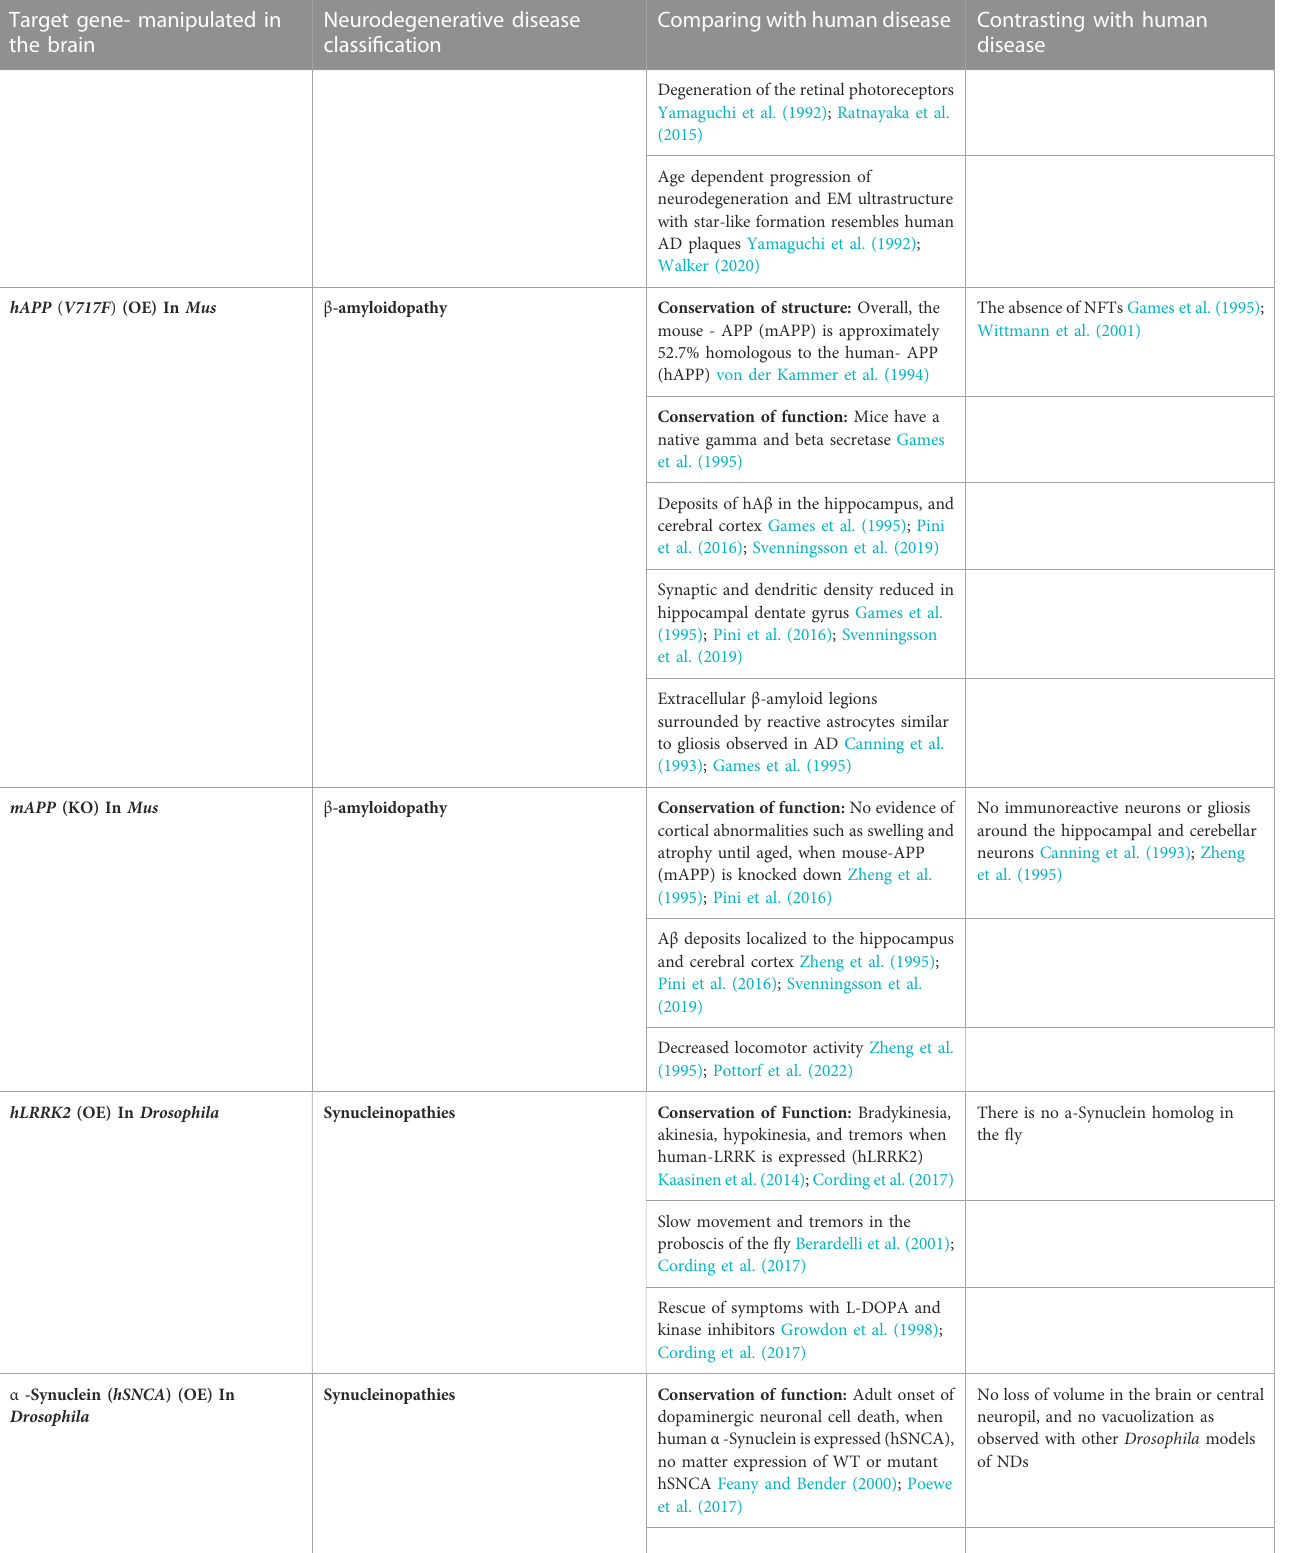
(OE) of hallmark genes for each of the three categories of neurodegenerative disease listed above. There is a column describing similarities in pathology between species and another column for differences. With each example made, there are references to the literature for more information about the model organism ’ s pathologies and similar or contrasting human pathology for